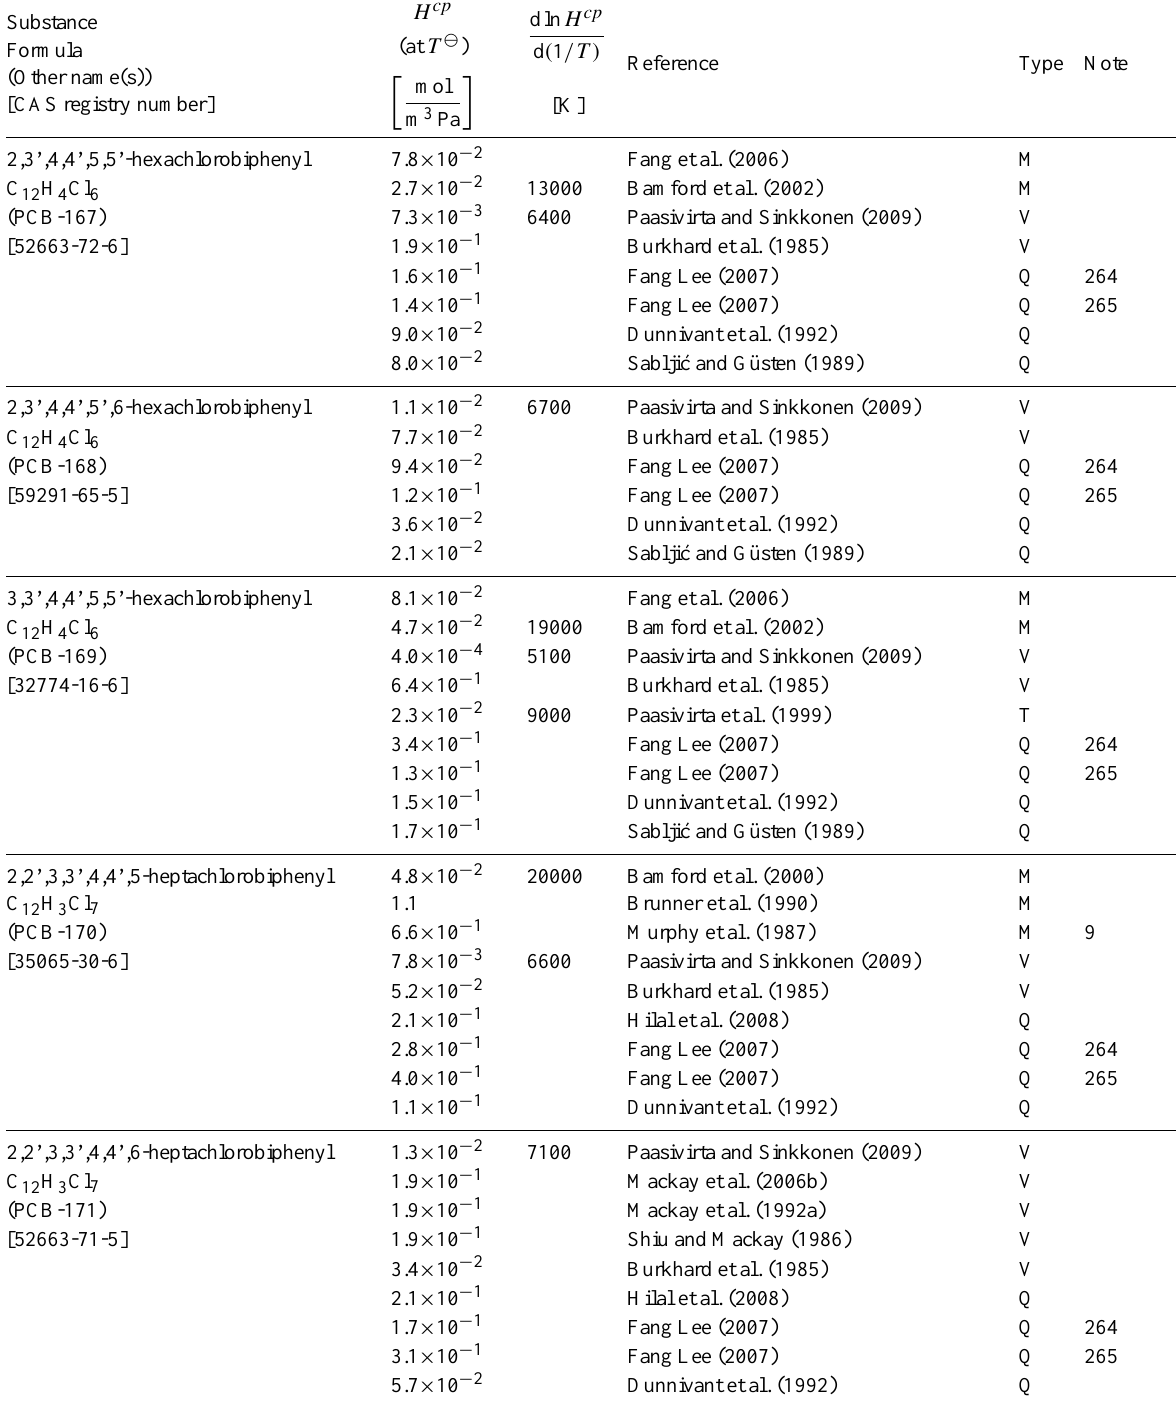
Table 6: Henry’s law constants for water as solvent